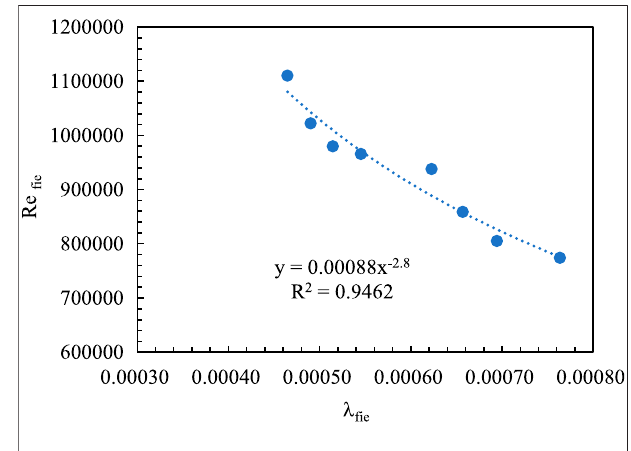
FIGURE 2 | Changes in Re lab with λ lab of slickwater in pipes with a diameter of 7.8 and 10.15 mm, respectively.